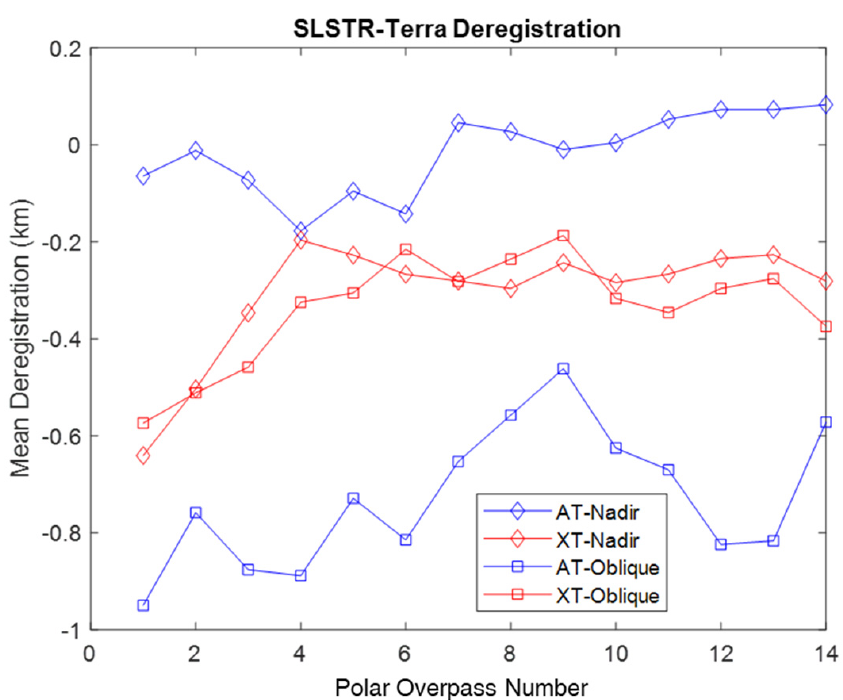
Figure 10. Sequence of registration compensations, resolved Along Track (AT) and Cross Track (XT), for the overpasses of Antarctica that are shown in Figure 7. The differences between the oblique and nadir curves would be the relative registration between the oblique and nadir views.